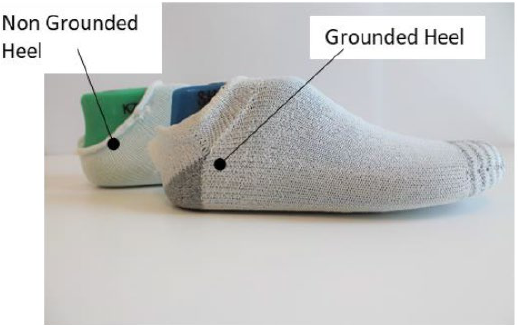
Figure 13. Two samples showing non-grounded heel (NGH) and grounded heel (GH) samples.